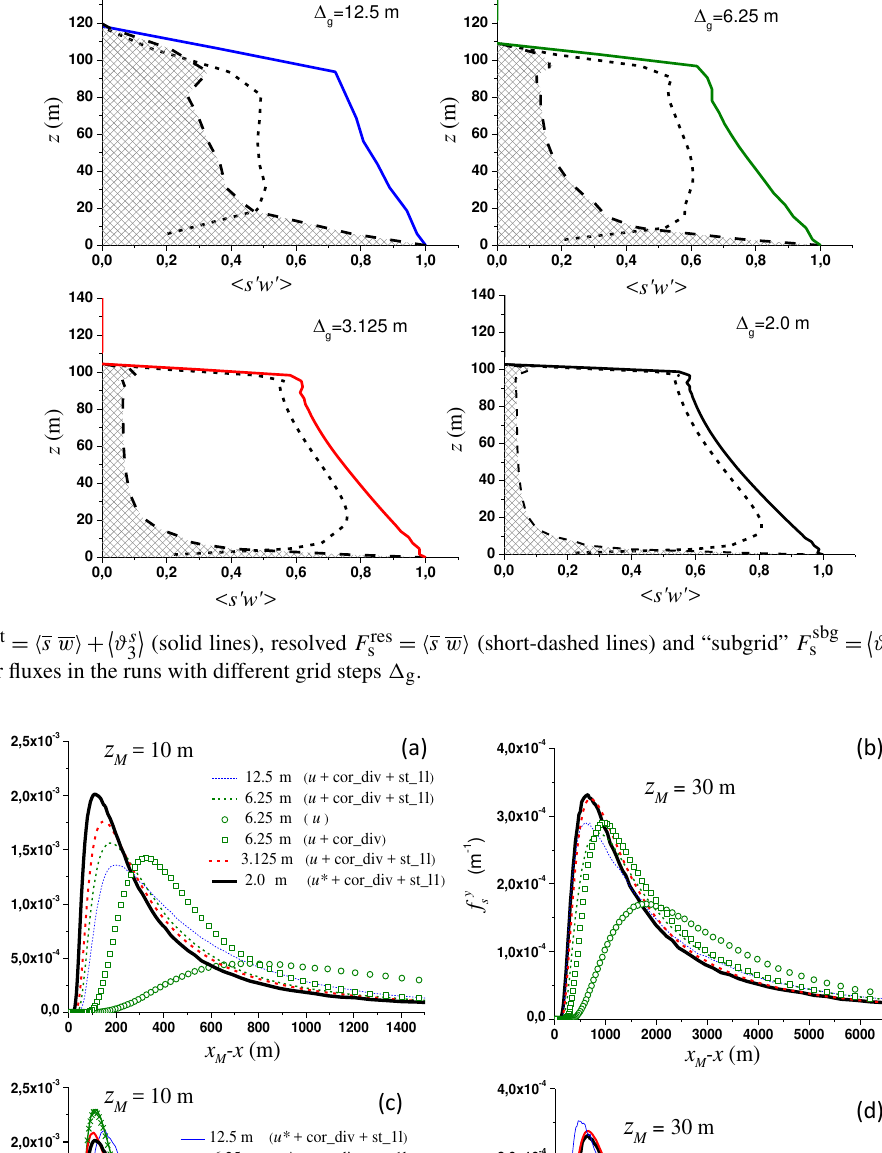
Figure 4. Crosswind-integrated scalar flux footprints f y s in the stable ABL, computed by different methods and with different grid steps: (a, c) sensor height z M = 10m; (b, d) z M = 30m. Grid steps and methods are indicated in the legend: u – particles are transported by a filtered LES velocity u ; u ∗ – particles are transported by recovered velocity u ∗ = F − 1 u ; cor_div – the additional correction of velocity (Eqs. 34 and 35); st_1l – the stochastic subgrid model (Eq. 28) is applied for the particles within the first computational grid